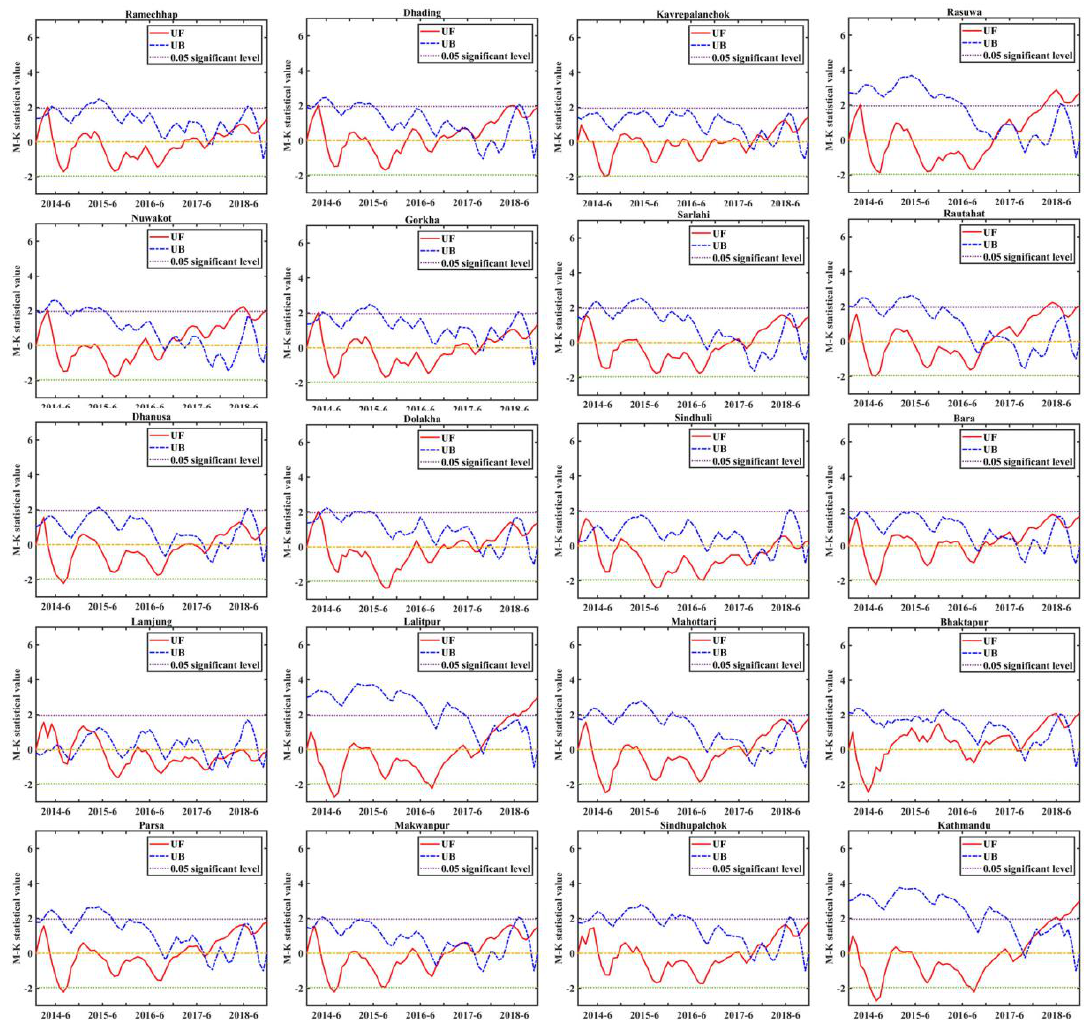
Figure 11. Mk mutation test. The red curve represents the UF (UF k statistical series) and the blue curve represents the UB (UB k statistical series). The dotted lines represent 95% confidence intervals. In the confidence interval, the intersection of UF and UB is the breakpoint.